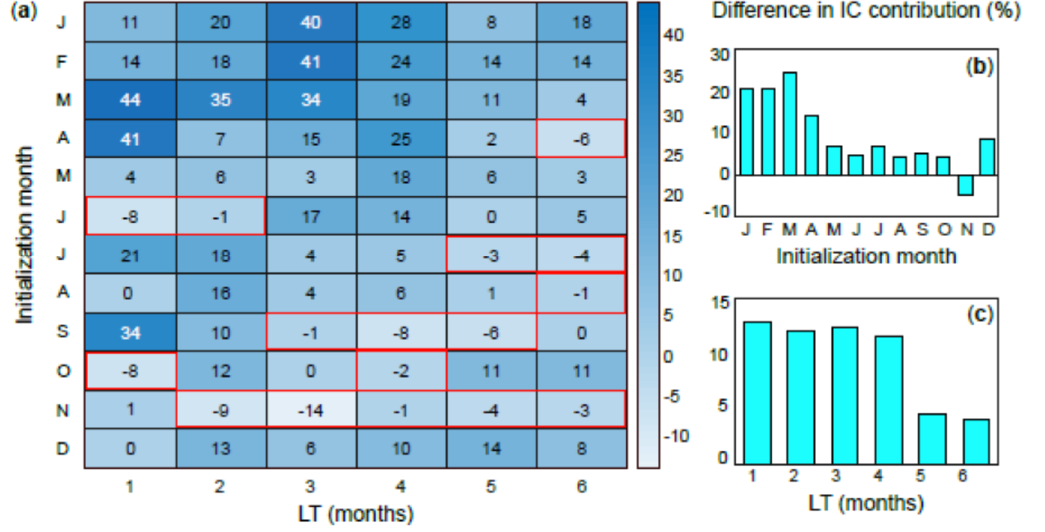
Figure 11. ( a ) Difference in IC contribution (in %) to the streamflow forecast skill for each initialization month (along each line) and LT (along each column) between the two case studies. Positive values indicate that the contribution of IC over the Gadera exceeds that over the Passirio, whereas negative values (included within the red-colored boxes) indicate the opposite. The averaged values over each initialization month ( b ) and LT ( c ) are also shown.